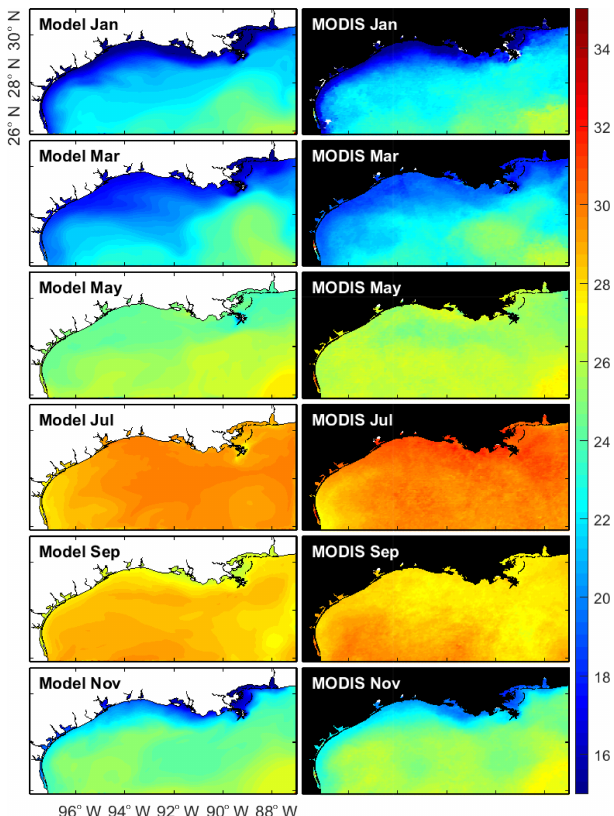
Figure 7. Temperature comparison (monthly average) between the model (left panels) and MODIS satellite data (right panels) for se- lected months in 2008.